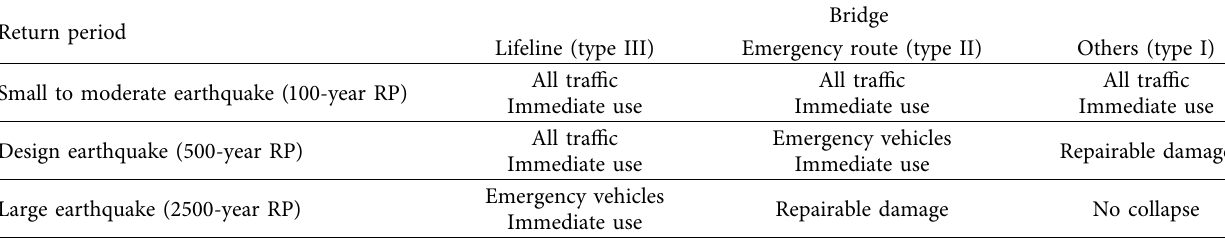
Table 1: Performance requirements in CHBDC codes (CAN/CSA-S6-06).